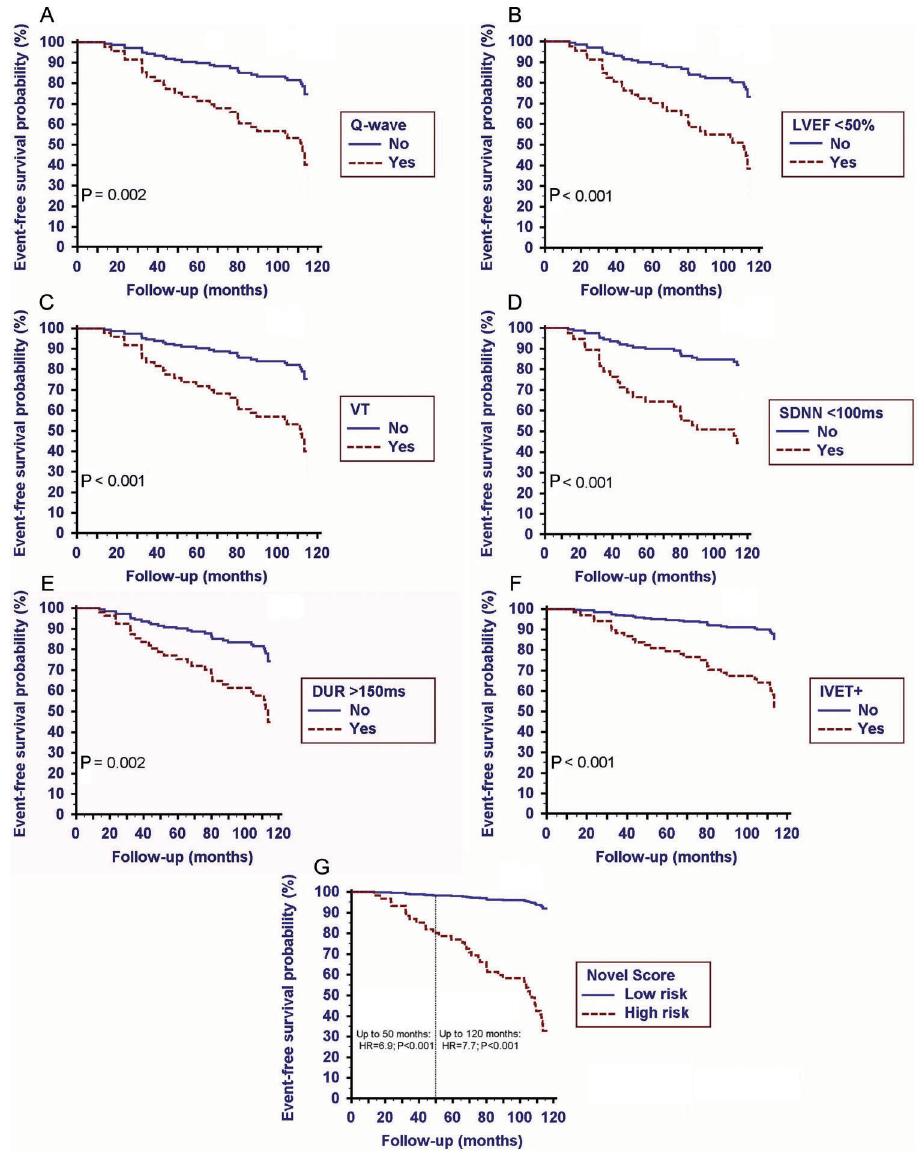
Figure 1. A , Kaplan-Meier event-free probability function of composite endpoint in univariate analysis for A , pathological Q-wave on 12- lead resting ECG (hazard ratio, HR=2.9; 95%CI=1.5-5.8; P , 0.002); B , left ventricular ejection fraction [(LVEF , 50%); HR=3.4; 95%CI=1.7-4.1; P , 0.001]; C , ventricular tachycardia [(VT) HR=3.6; 95%CI=1.7-7.1; P , 0.001]; D , 24-h standard deviation of normal RR interval [(SDNN , 100 ms) HR=4.1; 95%CI=1.8-8.8; P=0.001]; E , vector magnitude-filtered QRS duration on SAECG [(DUR . 150 ms); HR=3.0; 95%CI=1.5-5.9; P=0.002], and F , positive spectral turbulence on SAECG [(IVET++) HR=4.0; 95%CI=1.8-9.3; P=0.001]. G , Kaplan-Meier event-free probability function for composite endpoints according to follow-up time. High risk level: Novel score . 1; low risk level: otherwise, see text for